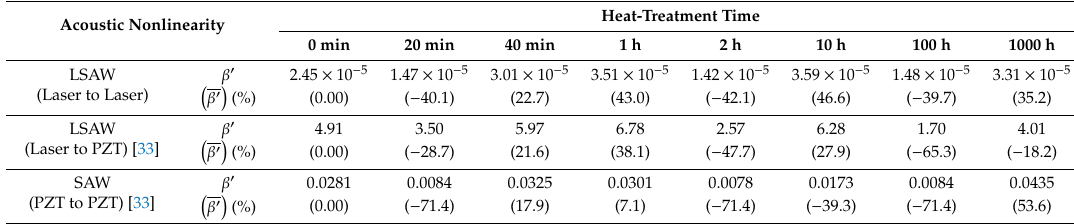
Table 2. Averaged relative acoustic nonlinearity parameters according to thermal aging and their fractional change between the intact specimen and the thermal-aged specimen. Acoustic